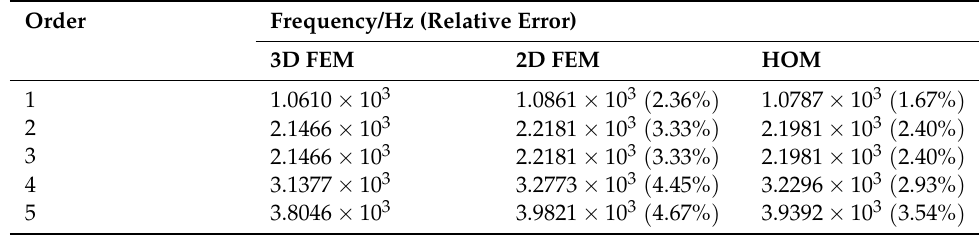
Figure 10. Third-order influence function χ 3 of the CCCC single-layer periodic plate. ( a ) mnp = 111; ( b ) mnp = 221; ( c ) mnp = 121; ( d ) mnp = 112; ( e ) mnp = 222; ( f ) mnp = 122.